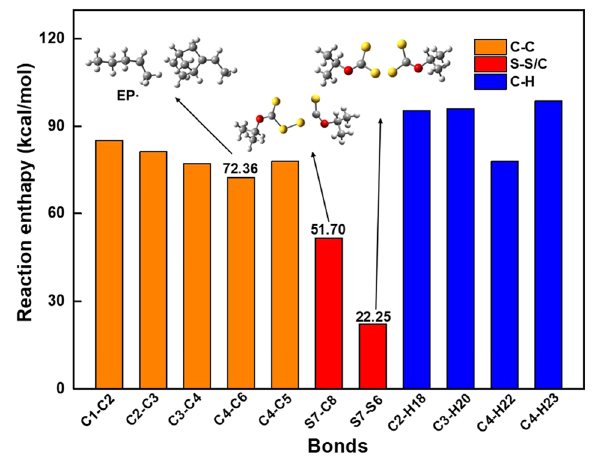
Fig. 9 Reaction enthalpy of different bonds of EPDM. Different colors stand for dissociation energies of considered